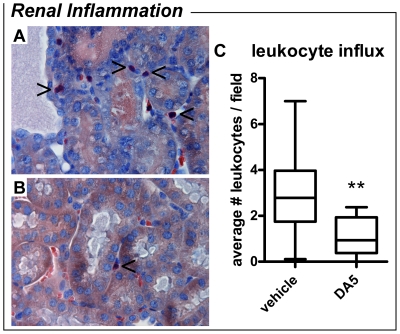
Diannexin (DA5) reduces leukocyte influx 3 days after I/R.Representative pictures of leukocyte influx in (A) vehicle-treated mice and (B) DA5-treated mice (magnification 400x). Granulocytes stained with Leder's esterase are indicated with arrowheads. (C) When compared to vehicle-treated mice, leukocyte influx in renal tissue of DA5-treated mice was decreased on day 3 after IRI induction. Values are means ± SEM. **P<0.01 vs. vehicle. n = 8–10 mice per treatment.